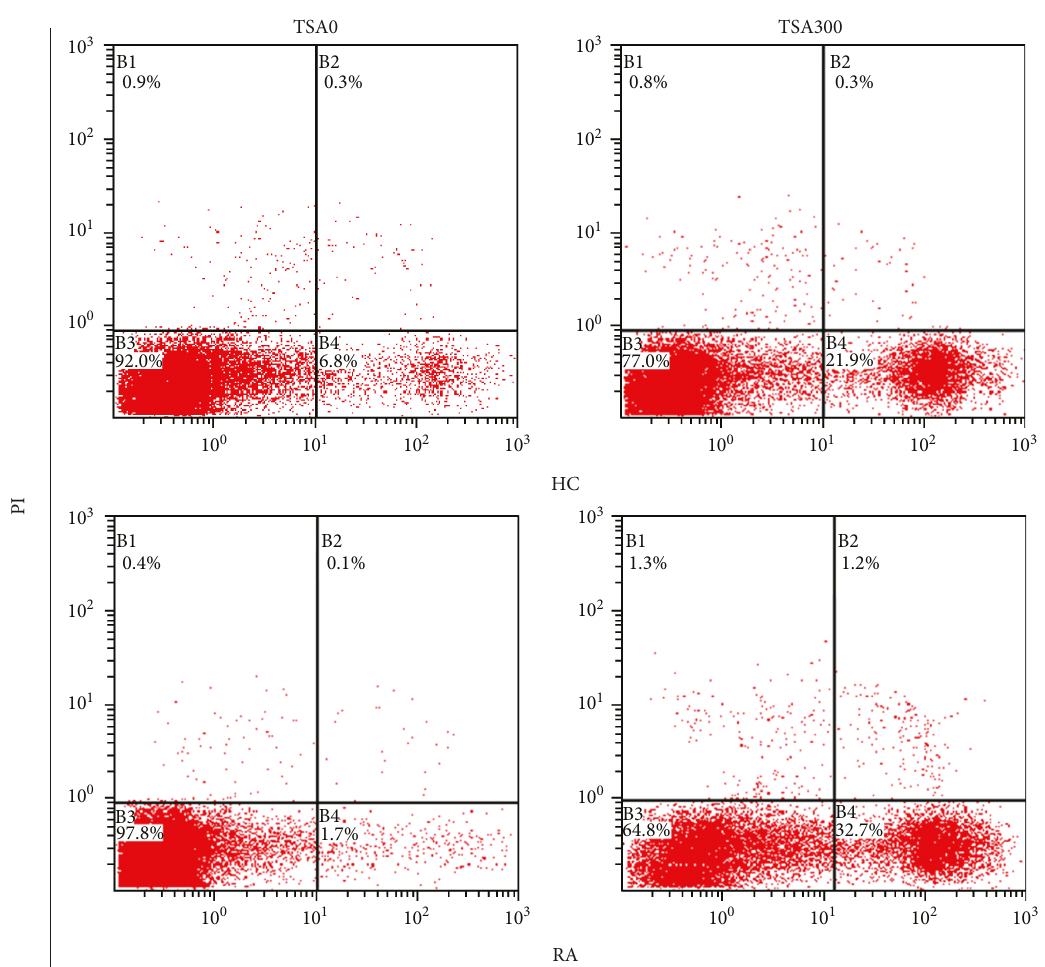
Figure 6: Apoptosis of PBMC cells from HC and RA treated with 0 or 300 nmol/L of TSA for 24